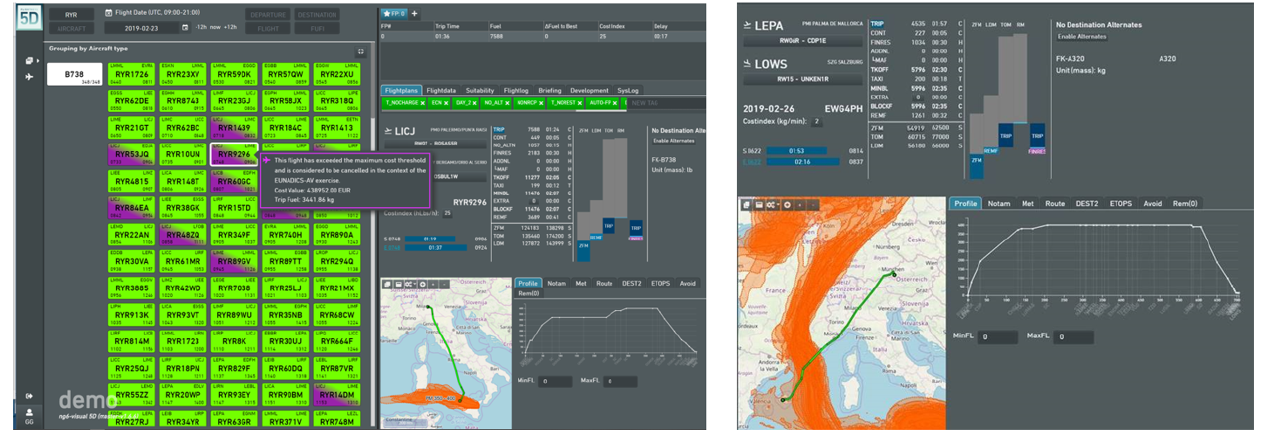
Figure 13. FLIGHTKEYS system during the EUNADICS-AV exercise. Left: overview of all monitored flights. Right: status (location, height, planned route) of an individual